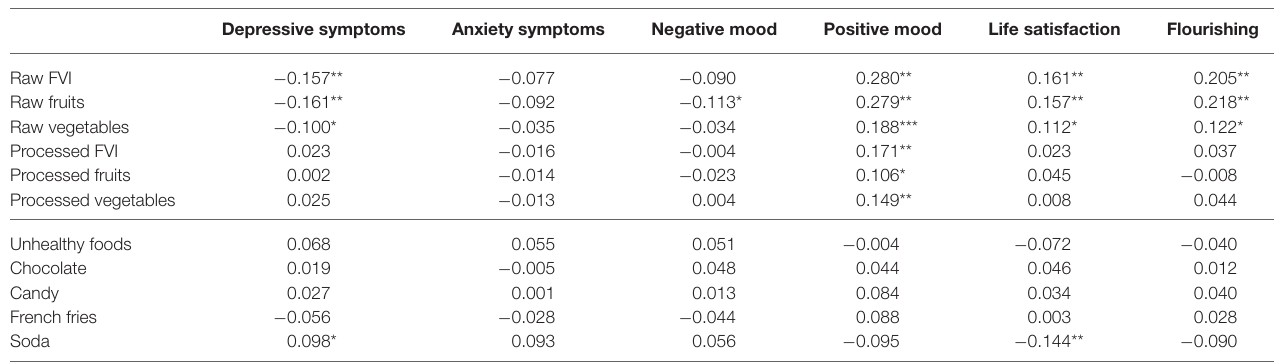
TABLE 4 | Bivariate correlations between intake of fruit, vegetables, unhealthy foods, and mental health. Depressive